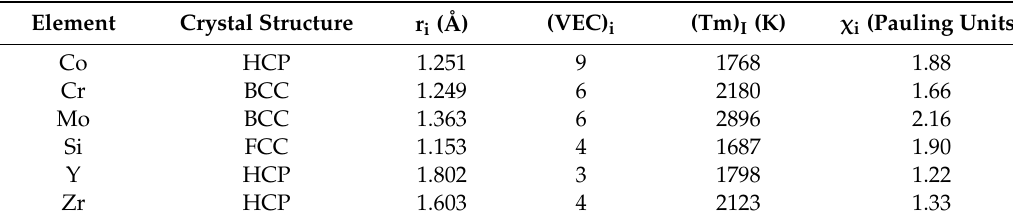
Table 1. Physical properties of pure alloying elements: crystal structure, atomic radius (r i ), valence body-centered cubic, FCC: face-centered cubic and HCP: hexagonal closest packed.